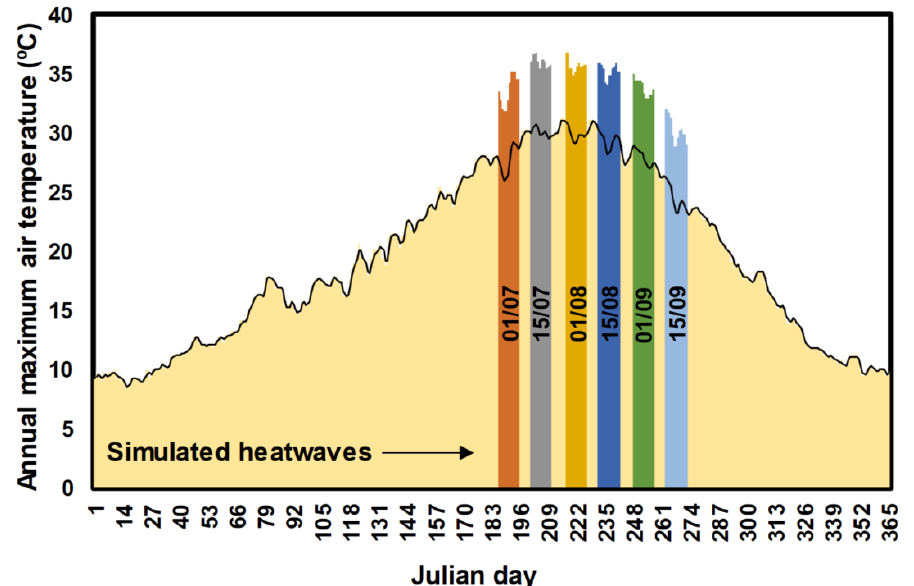
Figure 2. Illustrative representation of the synthetic heatwave disturbances/pulses during a calendar year, outlining their onset (dates within color bars), duration (color bar width) and intensity (color bar top). The observed temperature time series are represented by the background shaded graph, while the synthetic temperature time series of the heatwave disturbances are indicated at the top of each color bar.